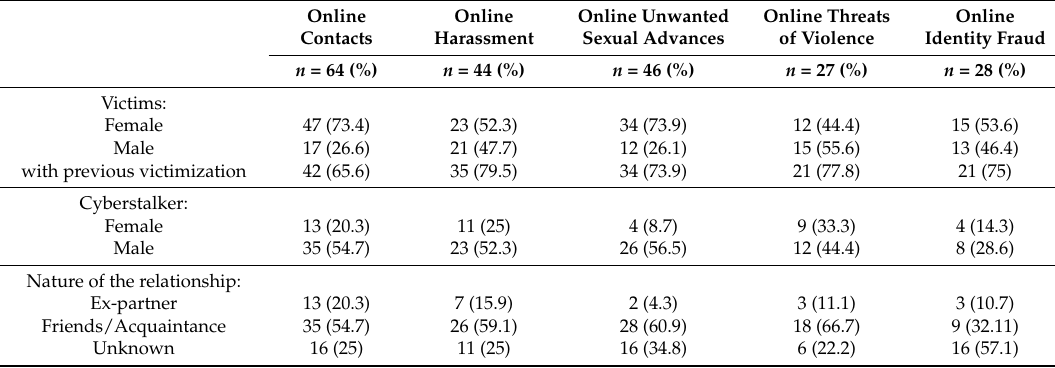
Table 1. Characteristic of the cyberstalking campaign ( N = 107). Values in percentage between brackets.